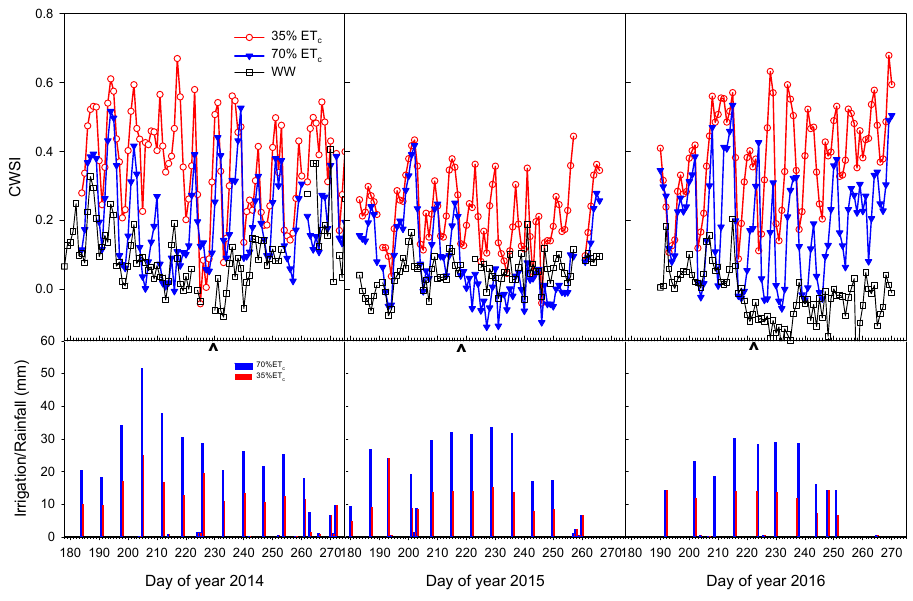
Figure 1. Average daily crop water stress index ( CWSI ) and irrigation applications to deficit irrigated treatments in 2014, 2015, and 2016. Computed CWSI of the well-watered vines (WW) is shown for reference. The ^ symbol denotes veraison day of year.